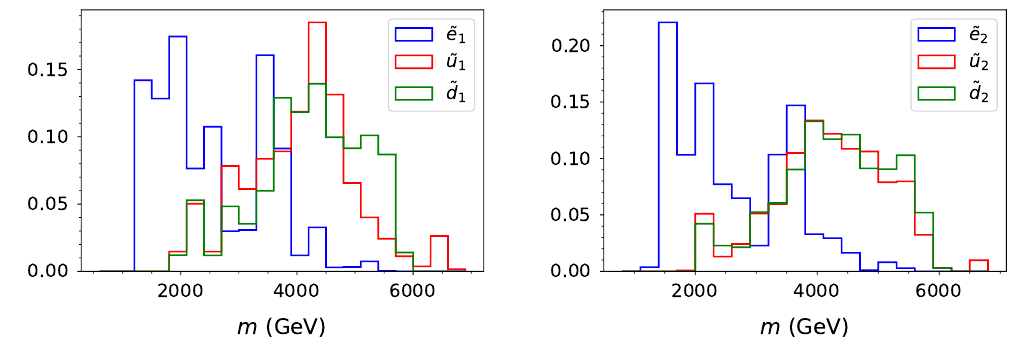
Figure 10 . Distribution of masses for the lightest up-type, down-type sfermions and the lightest slepton. The slepton is the lightest of these